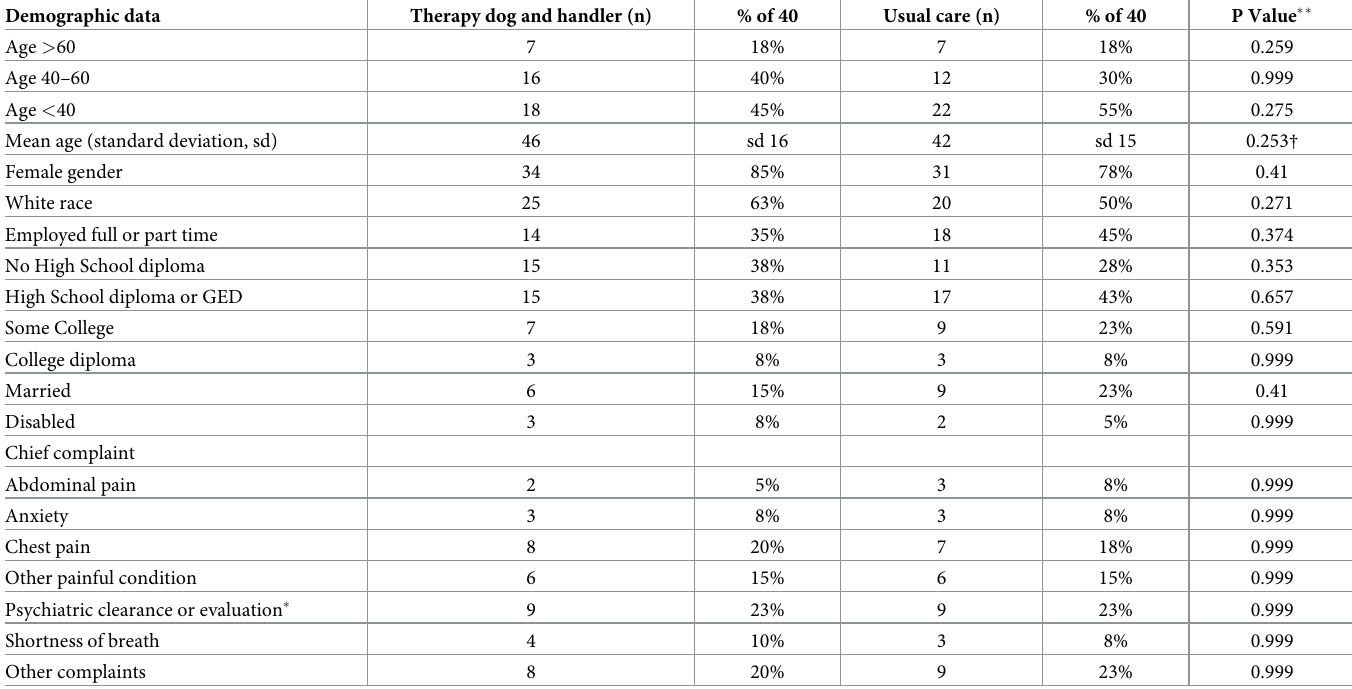
Table 1. Demographic features and chief complaints of patient